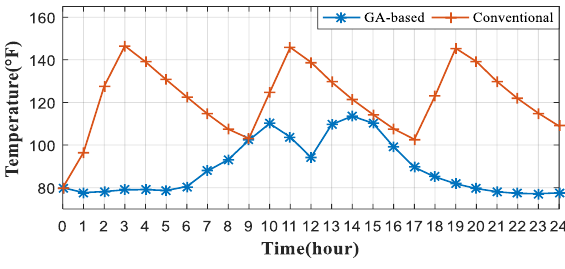
Figure 11. The 24-h EWH tank temperature.